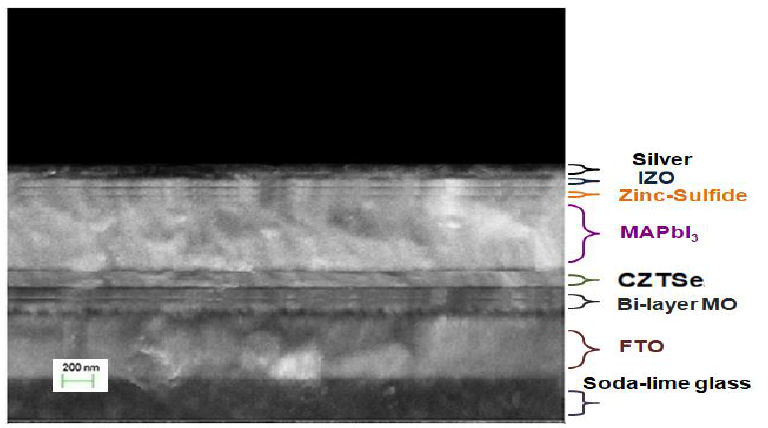
Figure 13. SEM cross-sectional micrograph of the Ag / IZO / ZnS / MAPbI 3 / Cu 2 ZnSnSe 4 / Mo / FTO nanostructures on glass